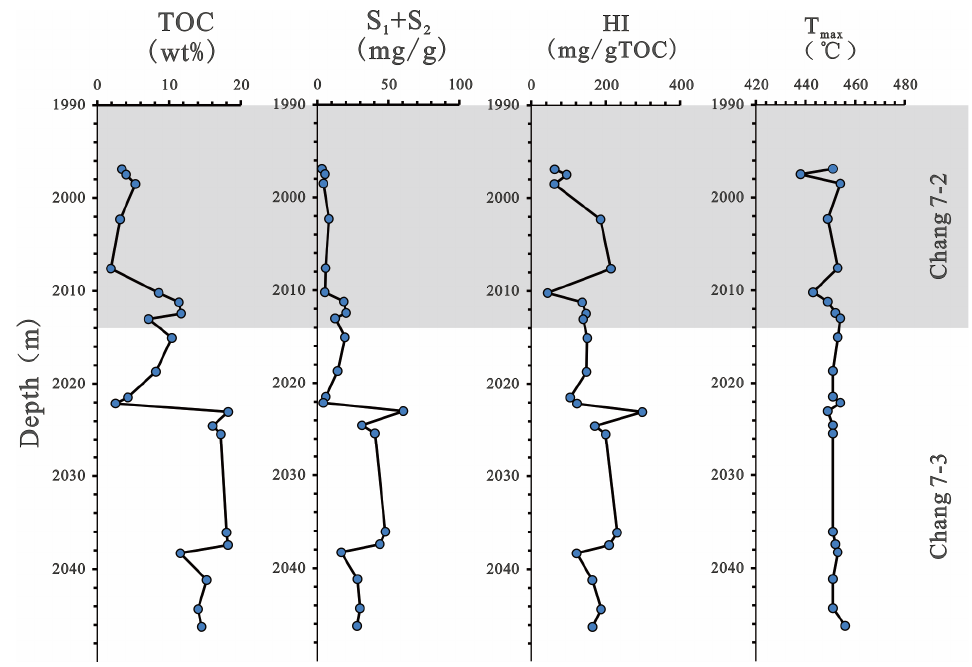
Figure 2. Vertical distribution of total organic carbon (TOC), generative potential (S 1 + S 2 ), hydrogen index and T max .